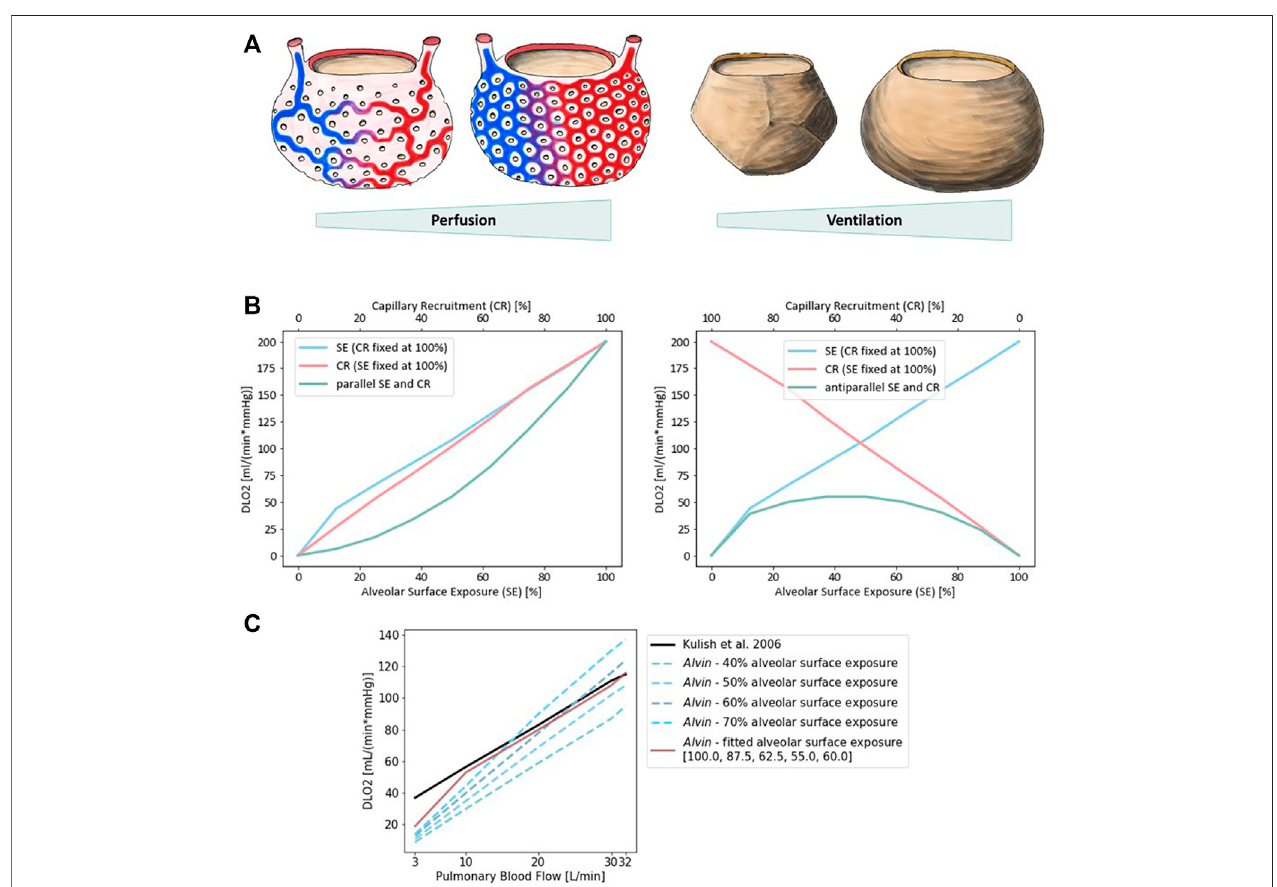
FIGURE 5 | Diffusion capacity of the lung for oxygen (D LO2 ) strongly depends on perfusion and ventilation. (A) Illustration of capillary recruitment (left) and alveolar expansion (right). (B) Diffusion capacity of the lung for oxygen (D LO2 ) depending on capillary recruitment and alveolar expansion for a parallel (left) and antiparallel combination(right).Alveolarexpansionandtheensuingsurfaceexposurearesimulatedin Alvin byincreasingalveolarsurfaceareafrom0(0%)to207,000 μ m 2 (100%)in steps of 12.5%. Capillary recruitment is represented by capillary blood volume increase from 0 (0%) to 808,000 μ m 3 (100%) in steps of 12.5% in Alvin . (C) ComparisontopublishedD LO2 estimates(Kulish,2006)(black).Pulmonaryblood fl owwasinterpretedasbloodvolumein Alvin ,assuminga fl owvelocityof1.5 mm/sand morphological features (mean capillary lengthof500 μ m (Weibel et al.,1993)and maximum volume ofalveolar capillarybed 808,000 μ m 3 (Gehr et al.,1978; Ochs et al., 2004)). Alveolar surface exposure was fi xed at constant values (blue dashed lines) and adjusted with increasing pulmonary blood fl ow (red